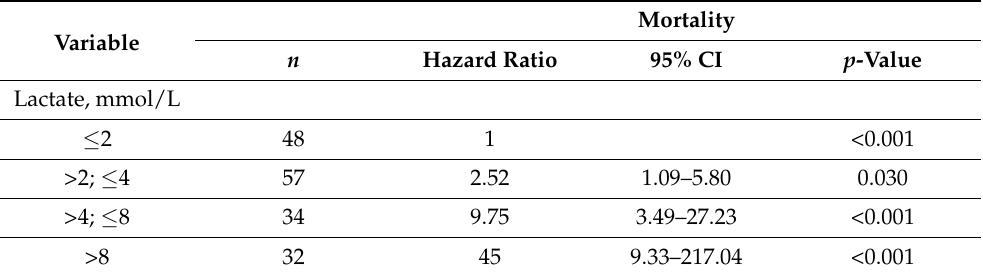
Table 4. Univariable analysis of in-hospital mortality divided in lactate subgroups.